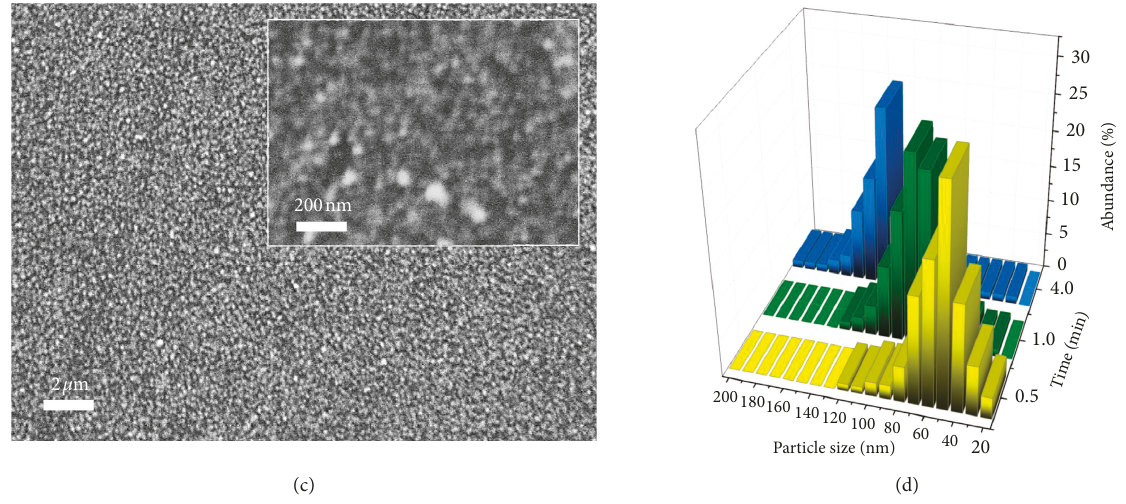
Figure 3: SEM image of the Si surface covered with gold deposited from a solution of 4mM H[AuCl for 0.5min (a), 1min (b), and 4min (c), and the size distribution histograms of AuNPs